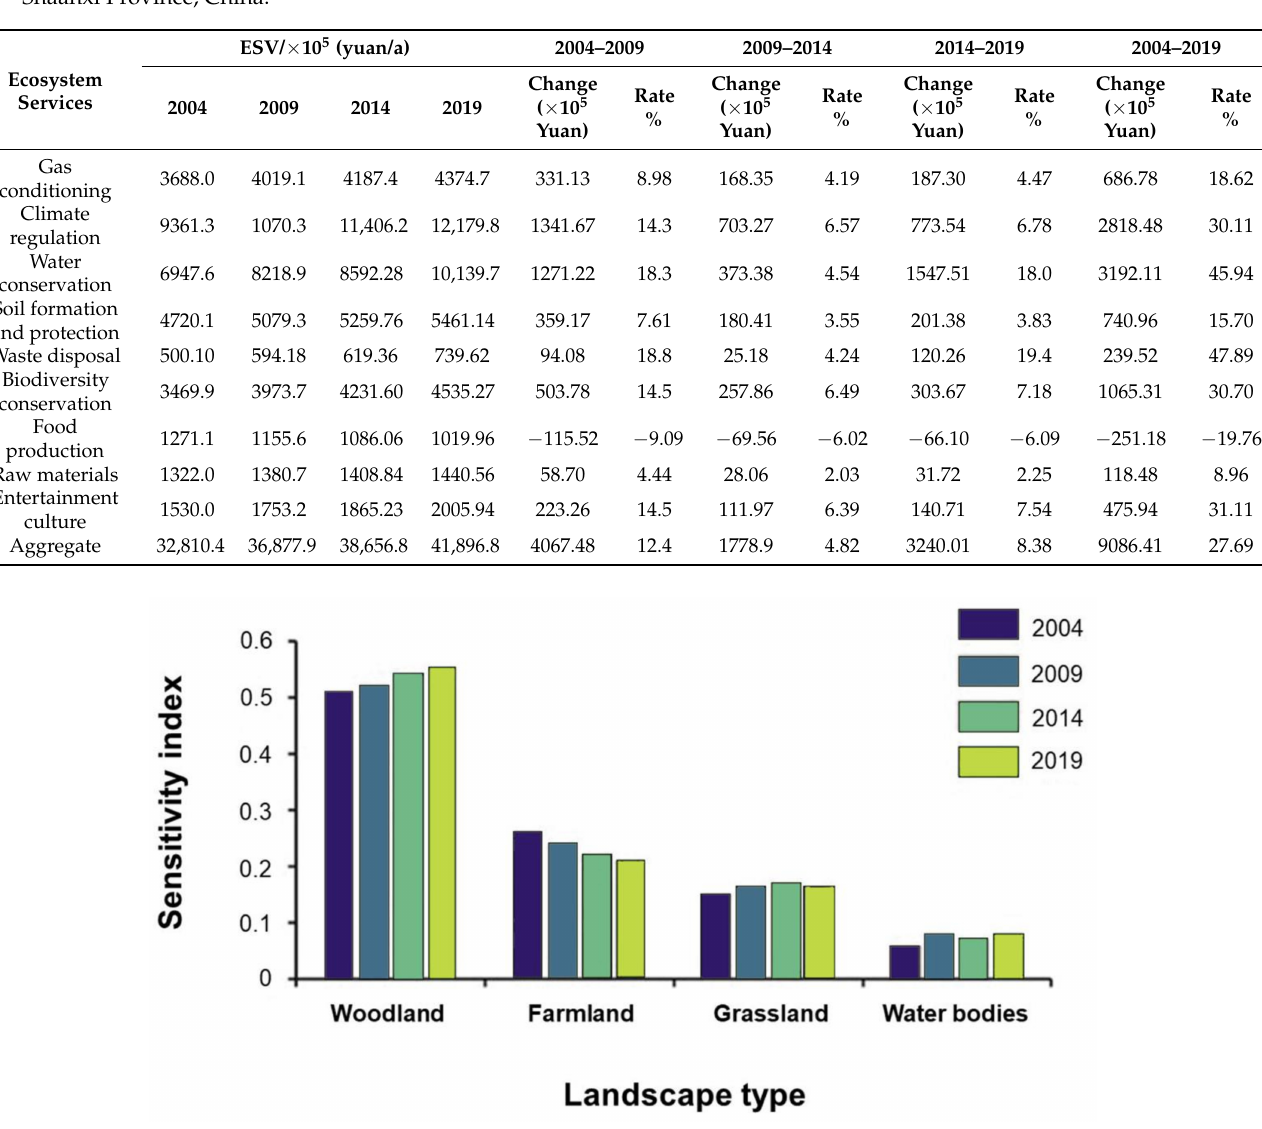
Figure 4. Changes on the sensitivity index for the landscape types from 2004 to